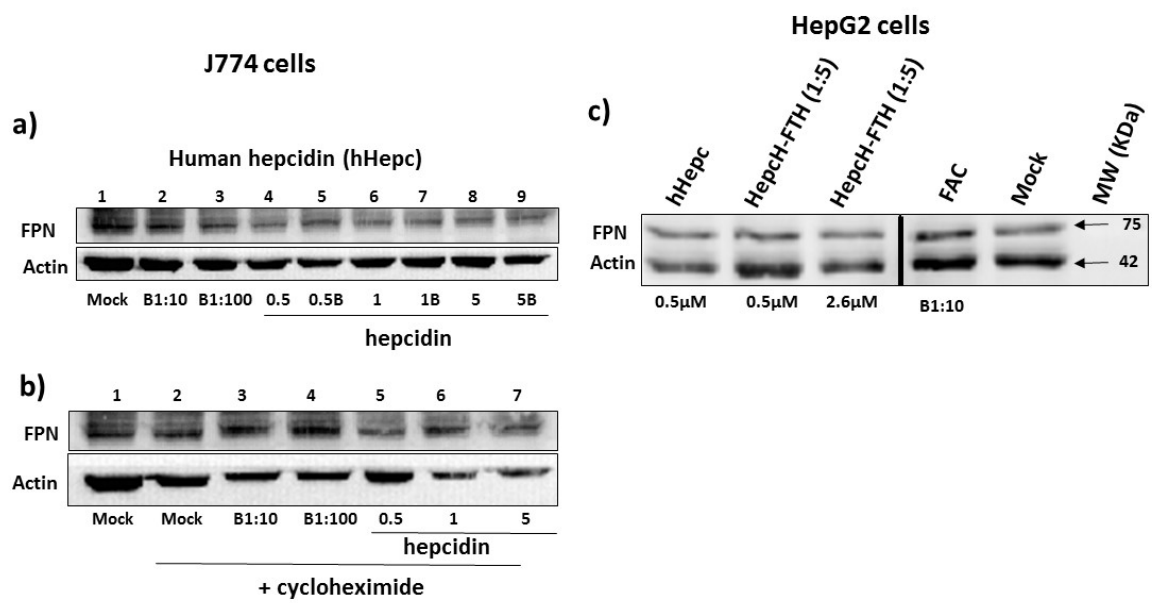
Figure 7. HepcH-FTH (1:5) promotes ferroportin degradation in HepG2 cells treated with iron. ( a ) Western blotting analysis of the denaturing 12%SDS-PAGE of J774 cell lysates after treatment with 0.5 μ M to 5 μ M human hepcidin (lane 4 to lane 9) during 2 h incubation using polyclonal anti-rabbit ferroportin antibody. Lane 1, mock (control). Lane 2, cells treated with 100 μ M FAC for 16 h to enhance ferroportin expression. Lane 3, cells treated with 10 μ M FAC. Lane 4, cells treated with 0.5